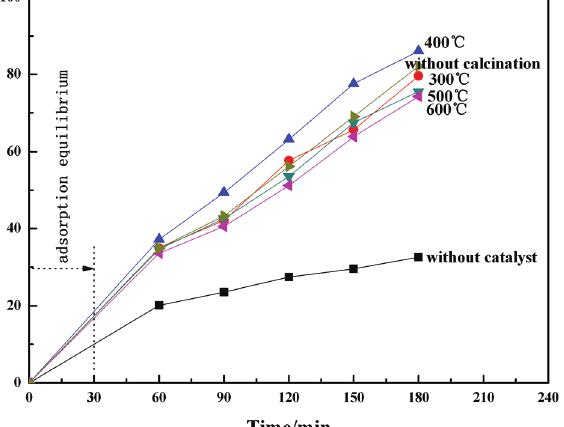
Figure 3: Degradation charts of BiVO 4 samples with different heat treatment temperatures.